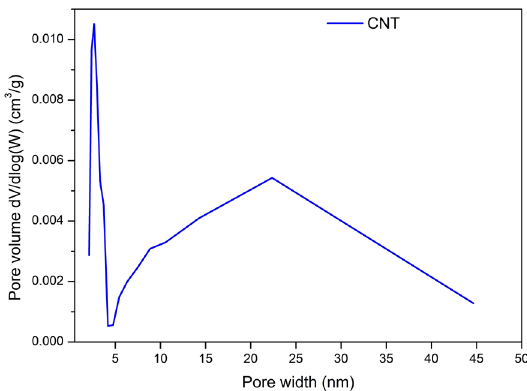
Figure 7. Pore size distribution of